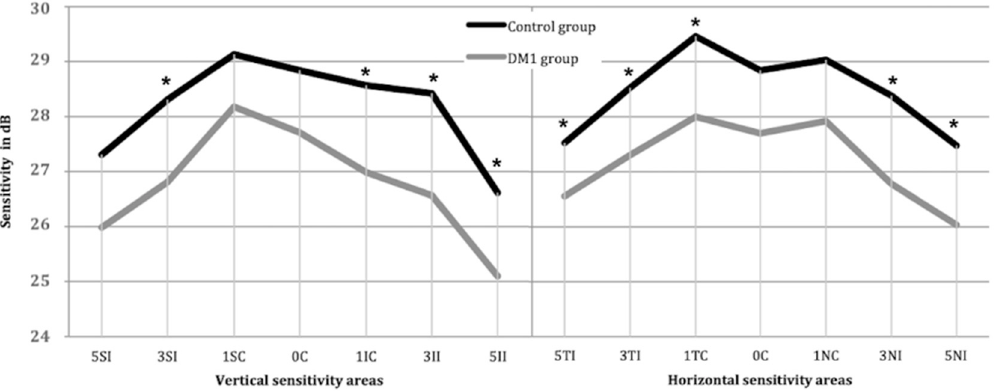
Figure 4. Mean retinal sensitivity in dB measured by the MAIA microperimeter in the ETDRS areas corresponding to the 3-mm parafoveal ring divided into 2 subrings (mean of 3 points per area at 5° and 3°) and the 1-mm central ring divided into 2 subrings (mean of 3 points per area at 1° and a central point): 5SI, 5° superior internal; 5TI, 5° temporal internal; 5II, 5° inferior internal; 5NI, 5° nasal internal; 3SI, 3° superior internal; 3TI, 3° temporal internal; 3II, 3° inferior internal; 3NI, 3° nasal internal; 1SC, 1° superior central; 1TC, 1° temporal central; 1IC, 1° inferior central; 1NC, 1° nasal central; and 0C, 0° central. Statistically significant differences are at p < 0.05 and are marked with *.